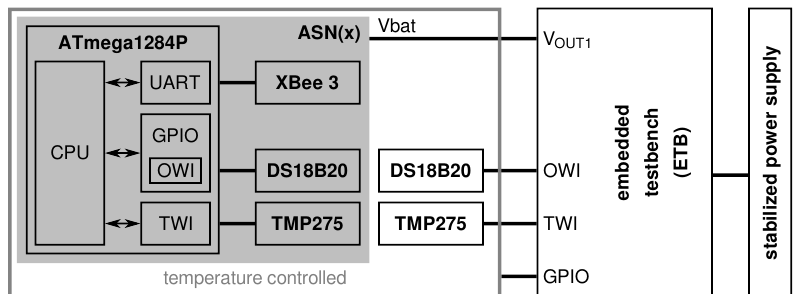
Figure 12. ETB-based lab experiment setup.